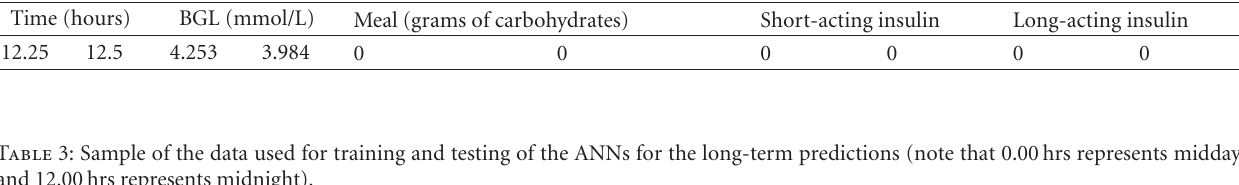
Table 2: A typical 2-event input vector supplied to the ANN for short-term predictions.